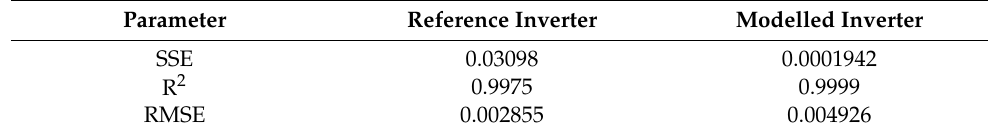
Table 2. Parameters of the approximation characteristics of the power efficiency.